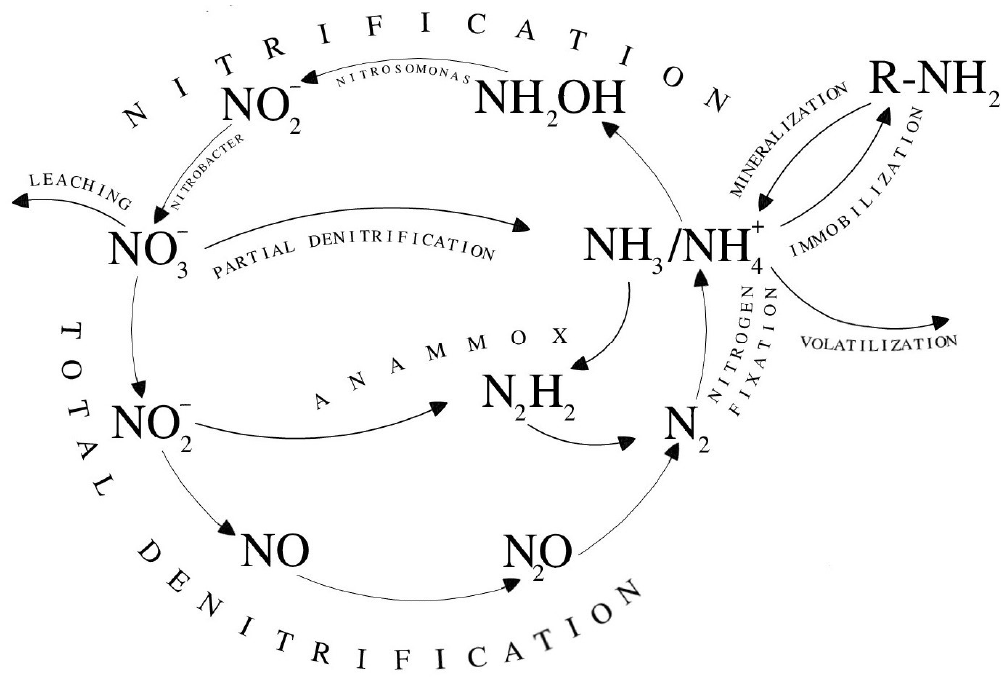
Figure 2. The nitrogen cycle. Source: Authors’ original compilation.